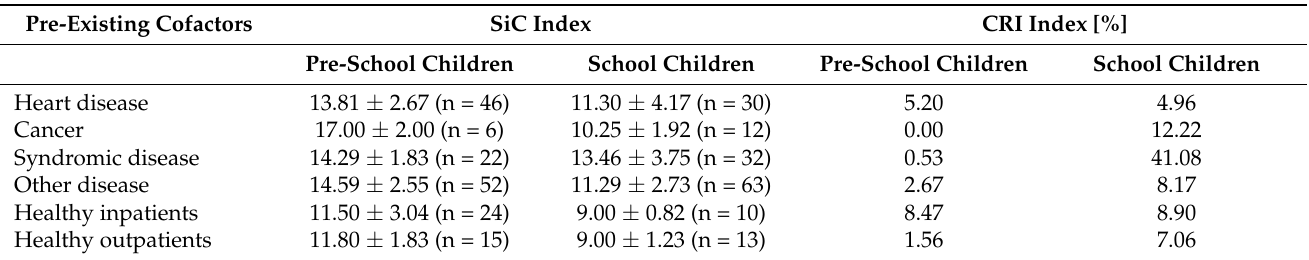
Table 1. Treatment need of all groups regarding Significant Caries Index (SiC) and Caries Restoration Index (CRI) for impulse 1.